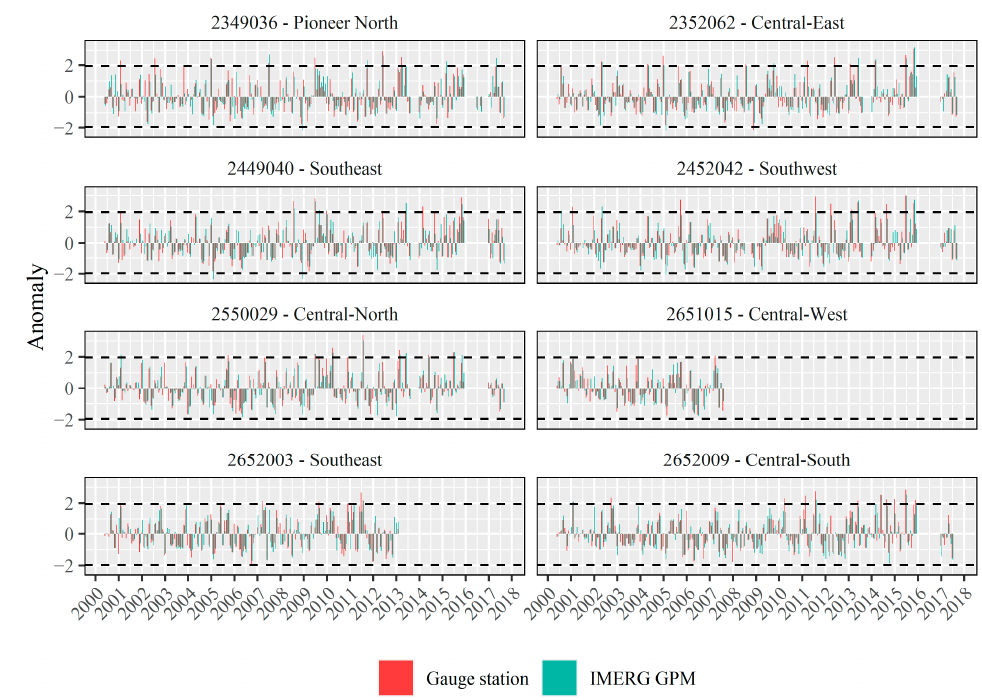
Figure 12. Anomalies for 9 stations selected at random. The dashed lines represent the values of − 1.96 and 1.96 σ (monthly standard deviation).